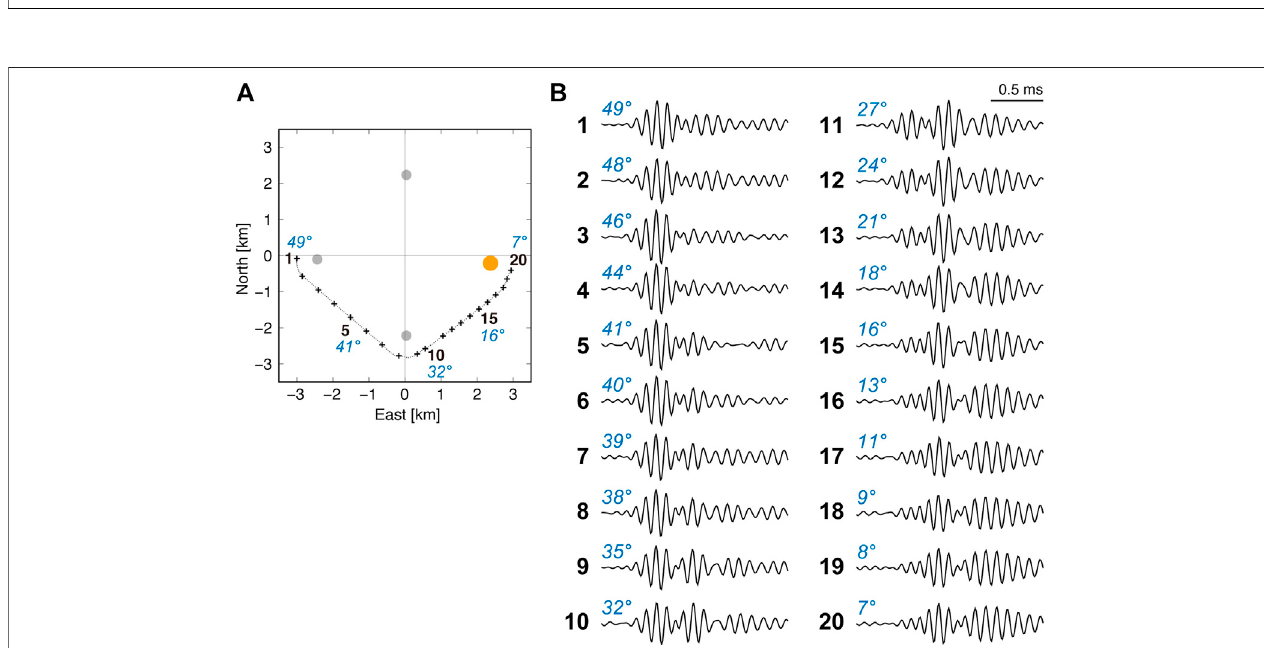
FIGURE 2 | Examples of actual cross-correlation between the reference and returned signals. (A) Part of ship tracks (small gray dots) of a campaign in a benchmark, which is settled on the sea fl oor at ∼ 4.8 km water depth and consists of four transponders (gray or orange circles) forming a ∼ 3.3 km square. (B) Cross- correlations of the reference and returned signals from the eastern transponder (orange). The numbers in black bold indicate ship ’ s positions shown by crosses in (A) . The fi gures in blue indicate incident angles of acoustic waves to the transponder (a vertical acoustic path has 0 ° incident angle).